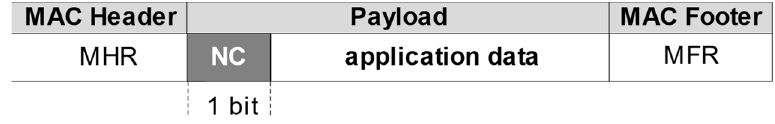
Figure 5. Proposed modification of the data frame for congestion notification.